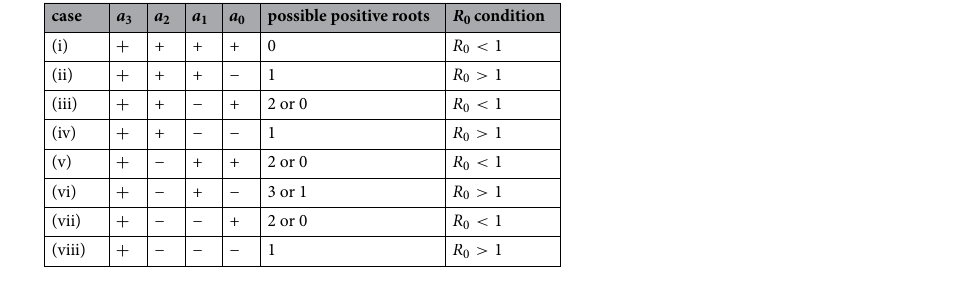
Table 1. Number of possible positive roots of Eq. (23) using Descartes’ rule of signs.